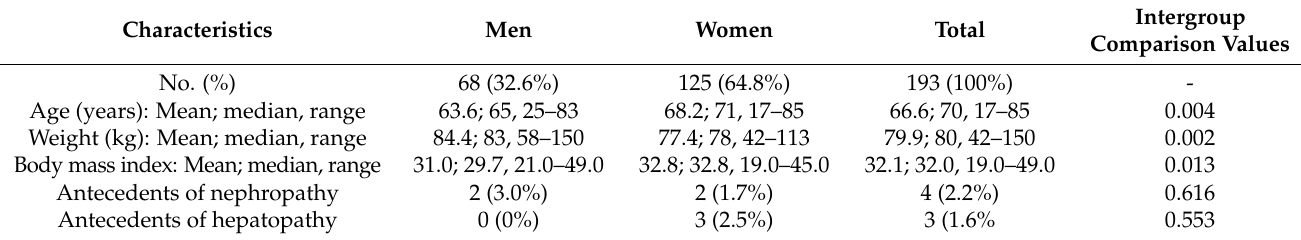
Table 1. Characteristics of the